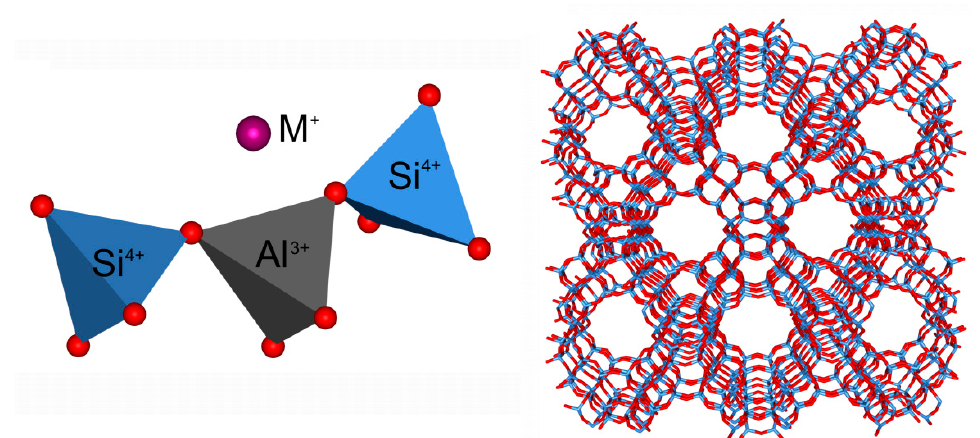
Figure 1. The basics of the structural chemistry of zeolites explained: zeolites are crystalline, microporous tectoaluminosilicates, wherein Si and Al atoms, collectively referred to as ‘T atoms’, are tetrahedrally coordinated by O atoms. These TO 4 units, connected by their apices (i.e., O atoms), form a three-dimensional network (left panel). Viewing the lattice as an ionic solid, the replacement of Si 4+ ions by Al 3+ ones creates an excess of negative charge, which is compensated by extraframework cations M + (e.g., H + , NH 4+ , metal cations).